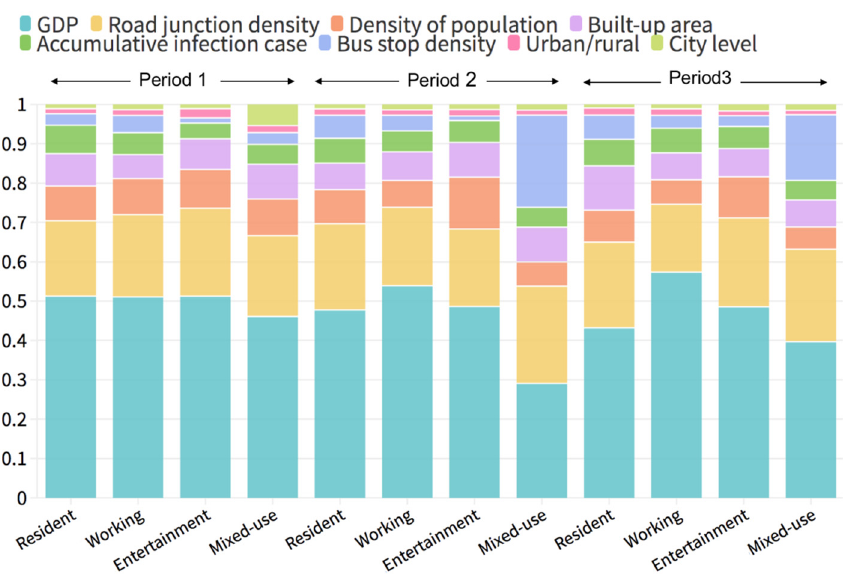
Figure 5. The importance of eight attributes on the change in human activity intensity in the different land-use categories in the three periods.